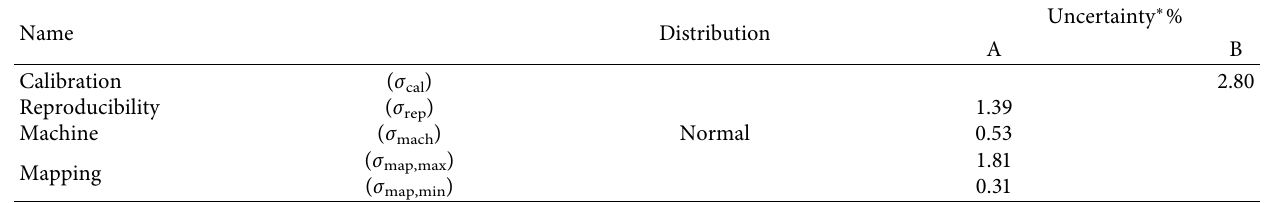
Table 3: Values of calculated or measured individual uncertainty.